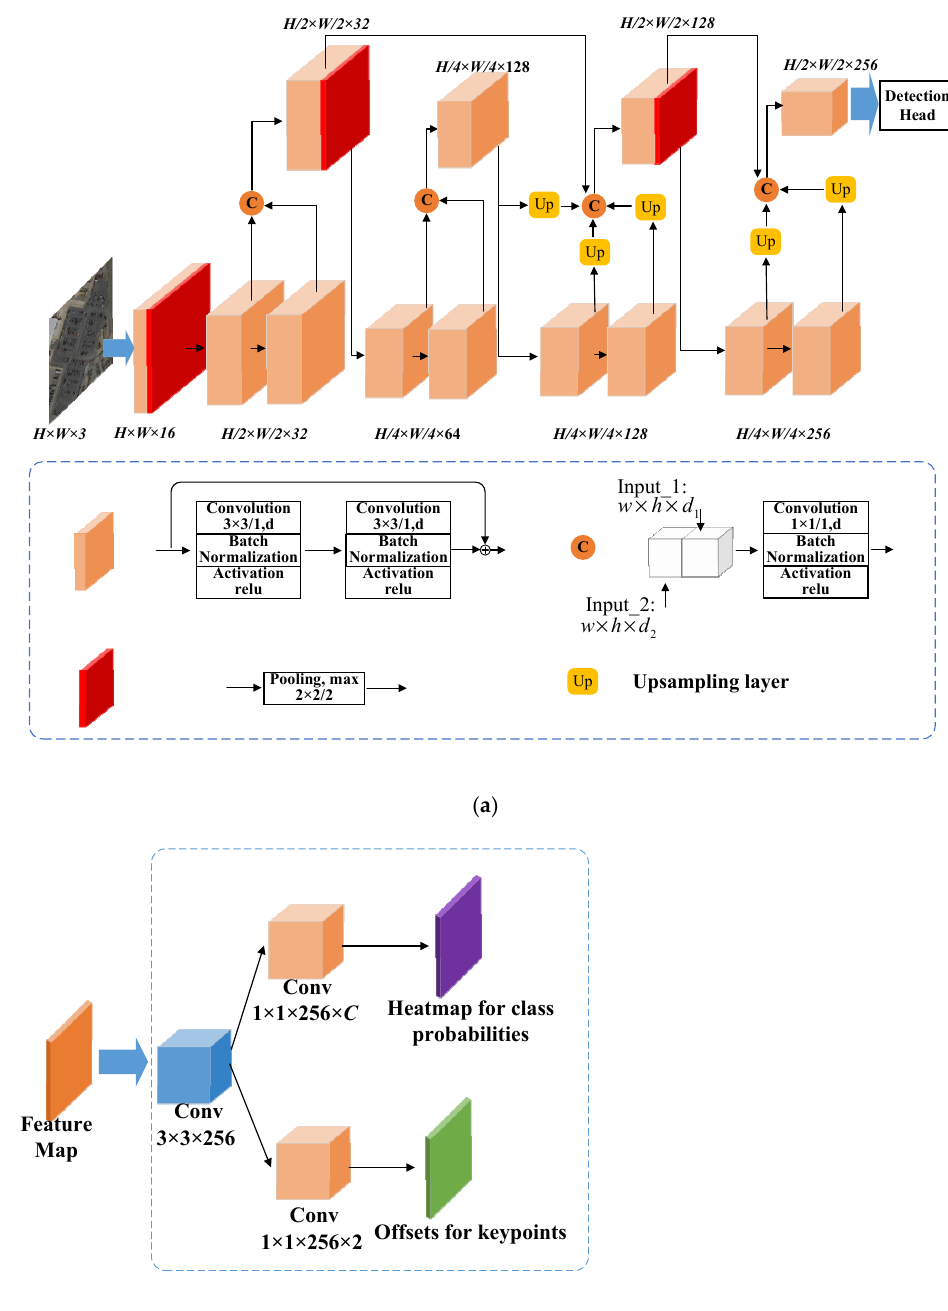
Figure 1. Overall architecture of the AVD-kpNet framework. H , W : height and width of input image, respectively. C : number of object categories. AVD-kpNet mainly comprises the feature extraction part and detection head. The upsampling layer is implemented by fractionally strided convolution. ( a ) Feature extraction part. ( b ) Detection head.